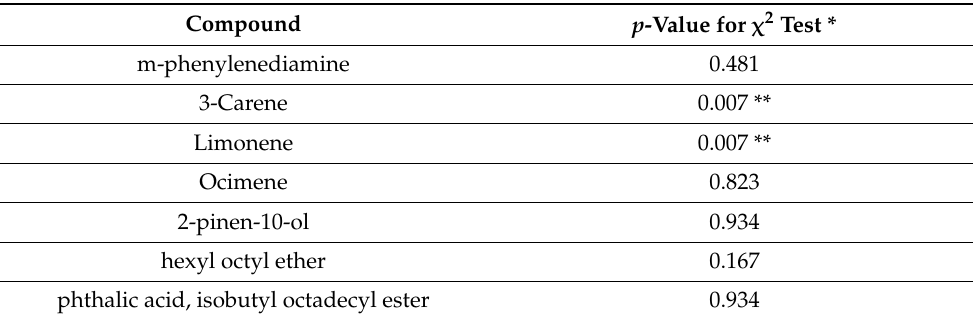
Table 3. Statistical evaluation of the differences between concentrations of VOCs emitted by brood taken from healthy and infected with P. larvae colonies. In both types of samples, the brood showed no clinical signs of P. larvae infection. Qualitative analysis.